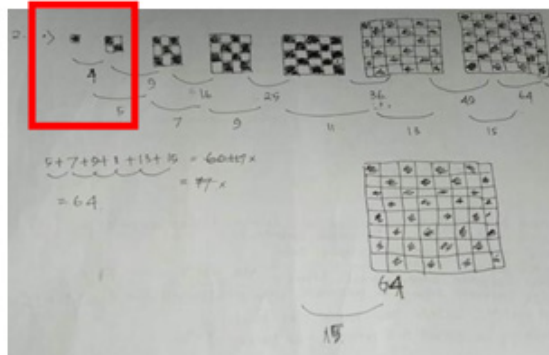
Figure 7. The Mathematics Anxiety